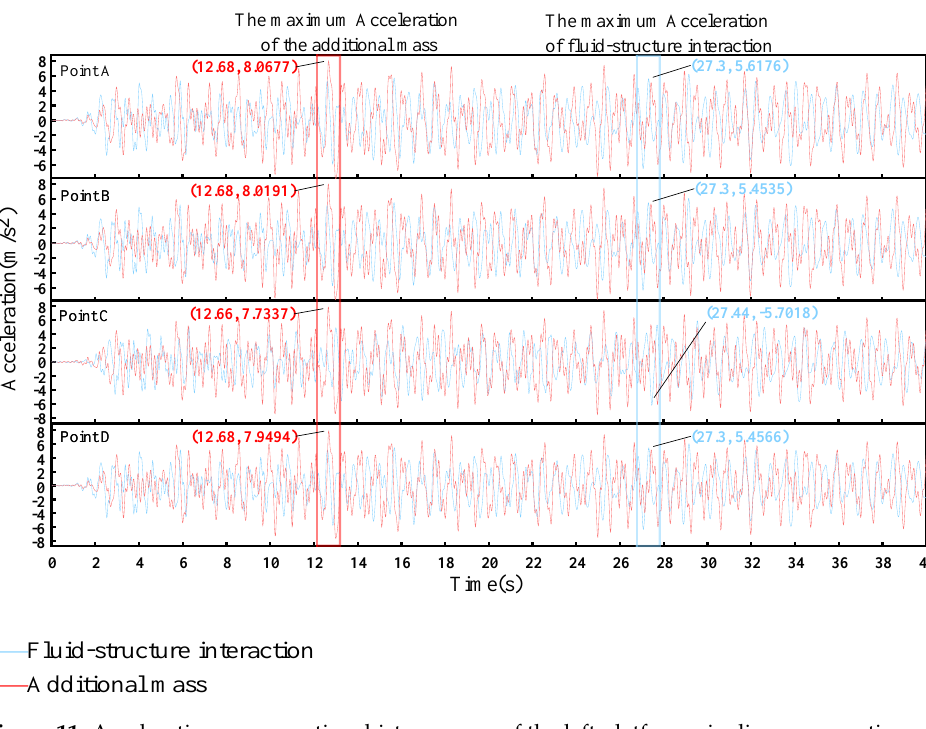
Figure 11. Acceleration response time history curve of the left platform pipeline cross-section.